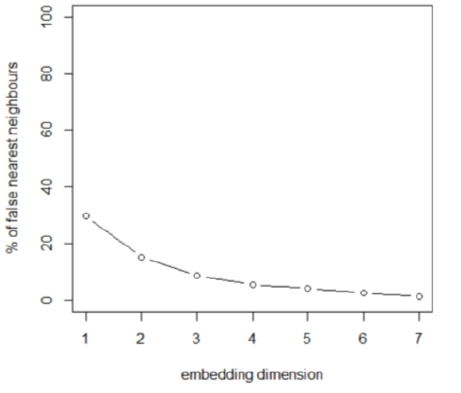
Figure 7: False nearest neighbours-Crude Brent oil; Source: Author